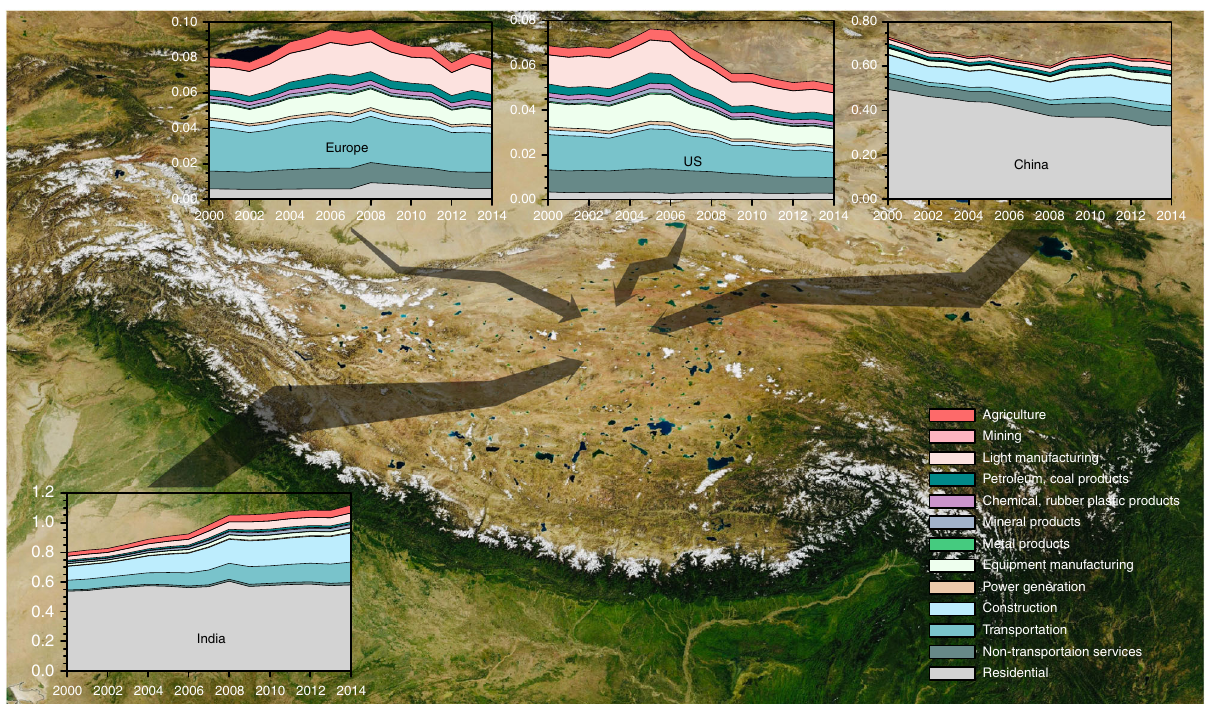
Fig. 4 Historical trends of consumption-based anthropogenic contributions to BC over the HTP glaciers. Annual-mean contributions (10 5 kg) from four different regions (i.e., the USA, Europe, China, and India) and 13 sectors to the BC mass-burden over the HTP glacier regions from a consumption perspective during the period from 2000 to 2014. The thickness of an arrow represents the magnitude of the contribution. The background image is a true- color satellite image from NASA Worldview Snapshots